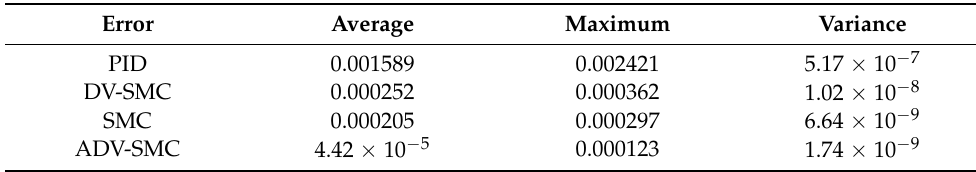
Table 3. Tracking errors of sinusoidal